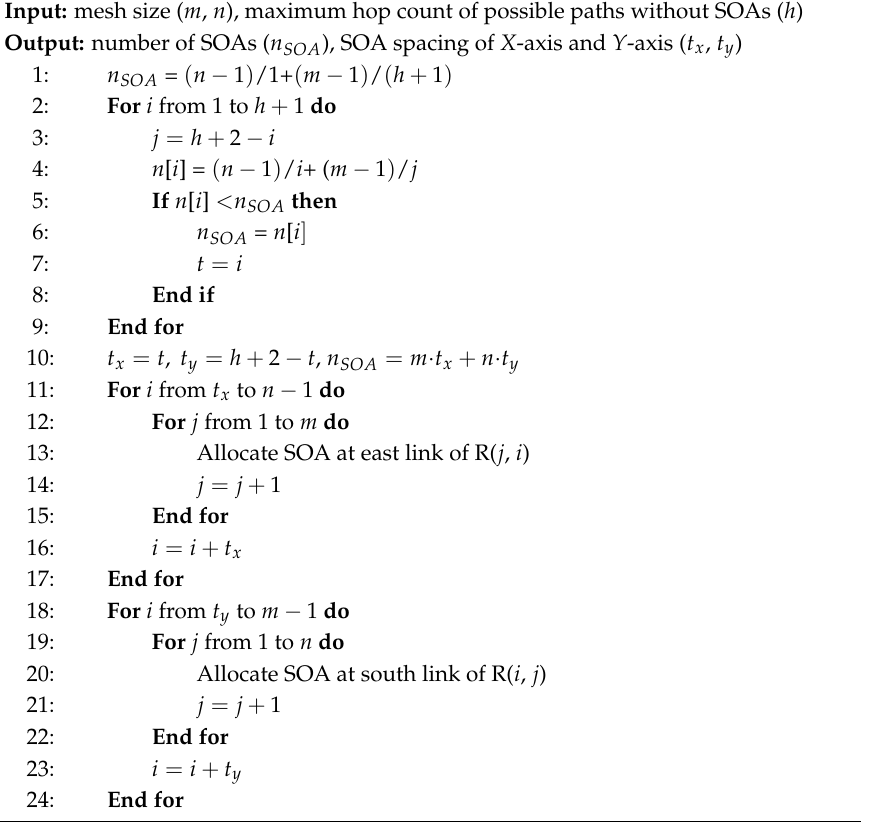
Algorithm 1. SOA Placement for Laser Source Power Saving and SNR Improvement